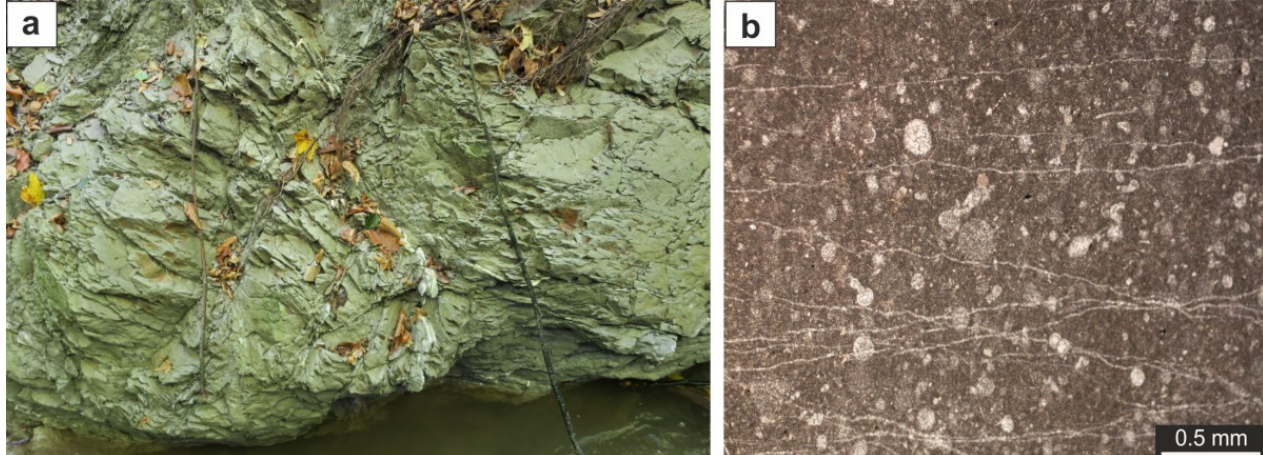
Figure 7. The Upper Cretaceous carbonate deposits in the Western Outer Carpathians: ( a ) Ż egocina Marls (Nowe Rybie); ( b ) wackestone with radiolarians and planktonic foraminifera (exotic clast from Ro ż nów near Nowy S ą cz).